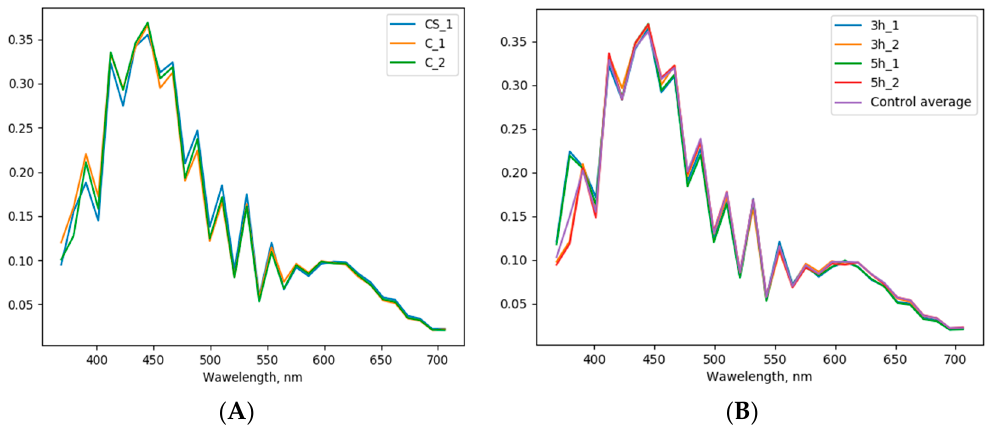
Figure 5. Component 1 of the pollen fluorescence amplitude obtained by the PCA method: ( A )—control group; ( B )—group of ozone-exposed pollen and control average. Y axis indicates dimensionless values in interval [0–1], values at 32 wavelength forms unit length vector.